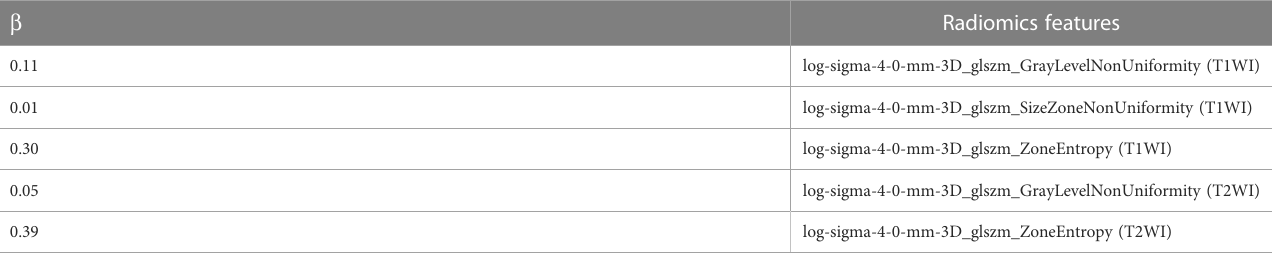
TABLE 2 The radiomics features selected by the least absolute shrinkage and selection operator logistic regression algorithm. b